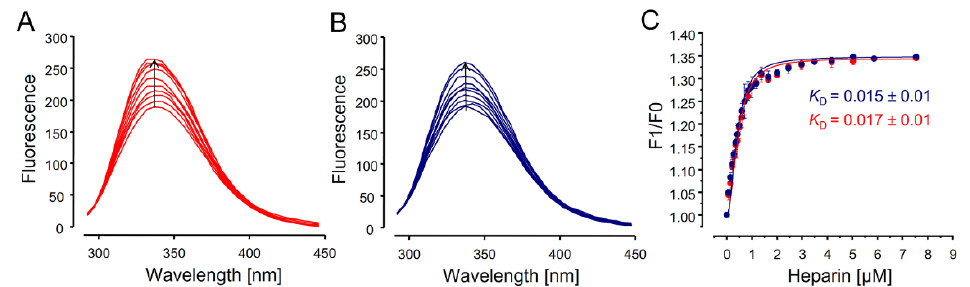
Figure 7. Fluorescence analyses to determine the interactions of pharmaceutical heparins with antithrombin. Panels ( A , B ) show the gain in antithrombin fluorescence promoted by the binding with heparins from manufacturers 1 (blue) and 2 ( red ). Titration curves derived from these data (as the mean ± SD of three batches from each manufacturer) shown in Panel ( C ) were used to calculate the dissociation constants ( K D ) for the interaction of heparin with antithrombin, as indicated in the panel.